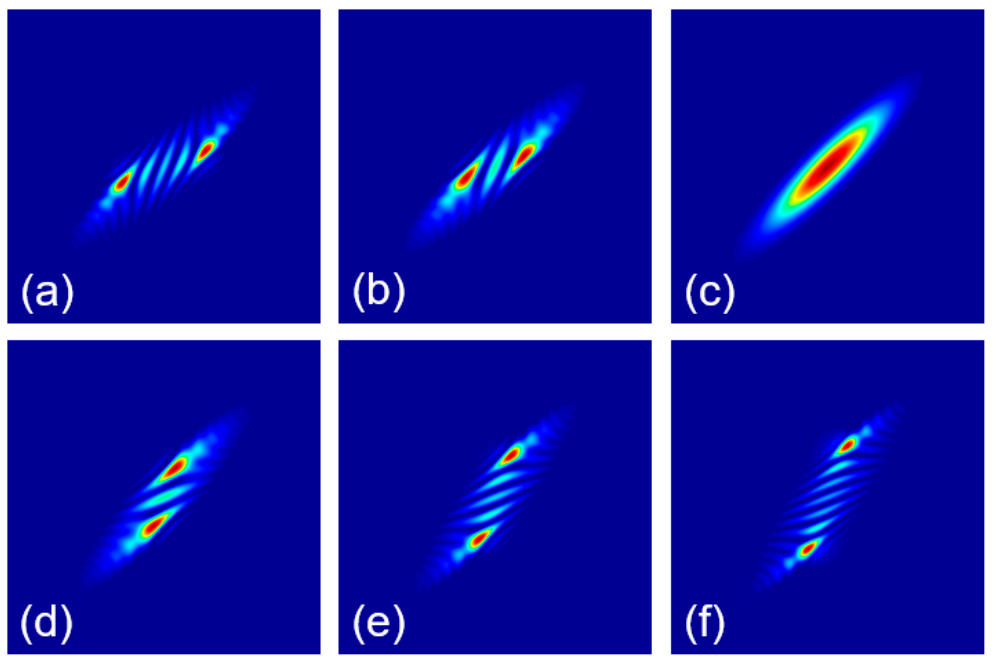
Figure 6. The spectral density of vortex beams under the effect of the twisting phase at z = 600 mm. The topological charge m equals ( a ) − 4, ( b ) − 2, ( c ) 0, ( d ) 2, ( e ) 4, ( f ) 6.